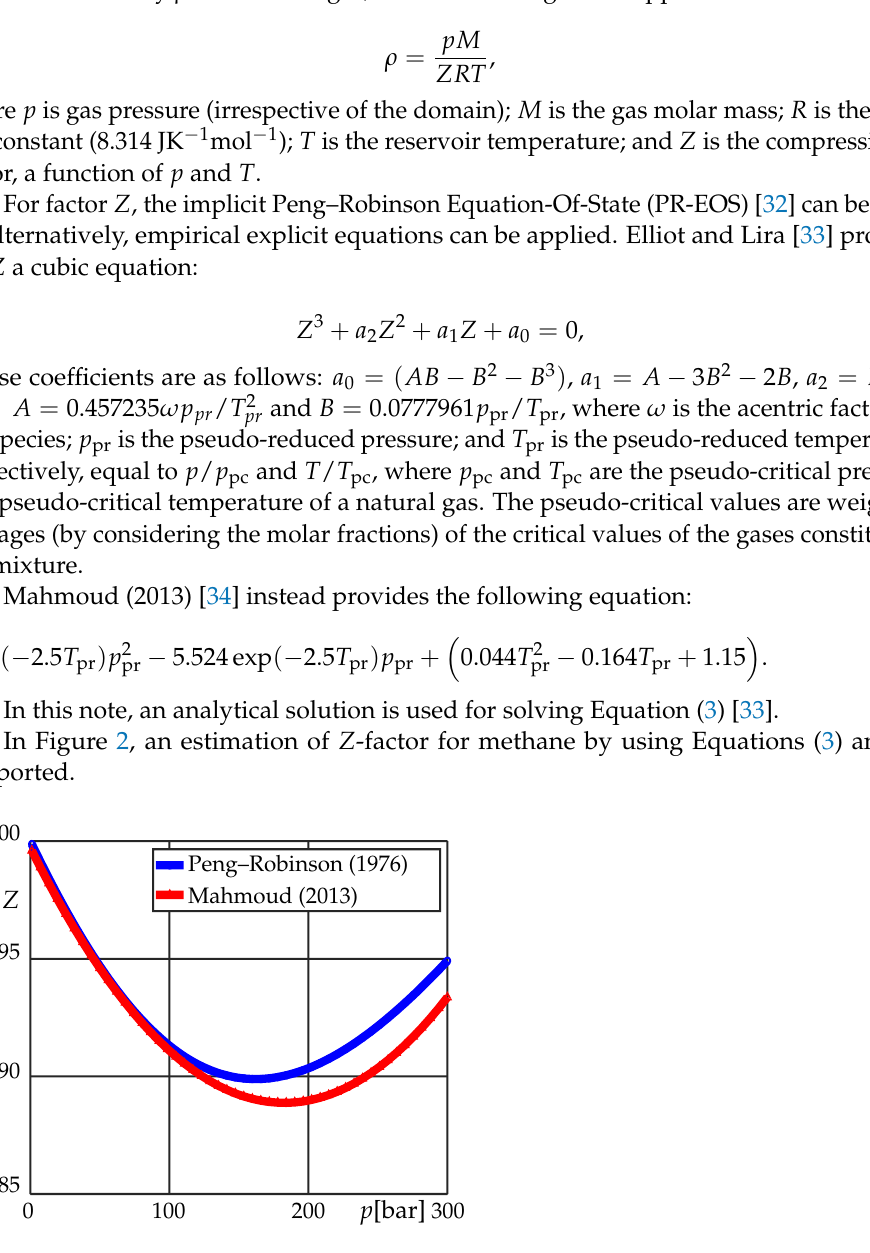
Figure 2. Natural gas Z -factor for methane estimated by Peng–Robinson Equation-Of-State (PR- EOS) [32] and empirical equation [34]; T = 352 K, T c = 191 K, p c = 4.64 MPa, R = 8.314 JK − 1 mol − 1